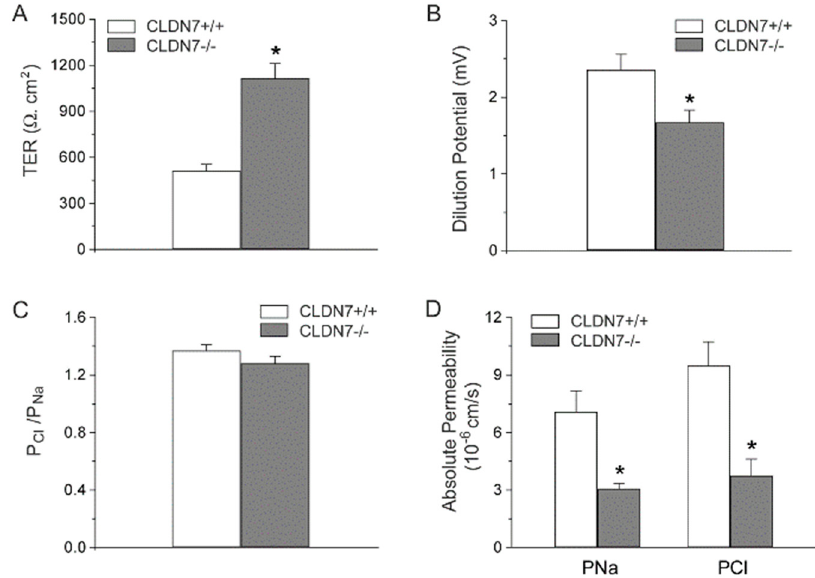
Figure 2. Deletion of CLDN7 increased transepithelial resistance (TER) and decreased paracellular Cl − and Na + permeability on CD cell monolayers. ( A ) TER was measured on monolayers cultured for 7 days. ( B ) CD cells were grown on collagen-coated Snapwell filters for 7 days to reach the full confluence. The filter rings containing cell monolayers were mounted into EasyMount chambers. Both apical and basal chambers were filled with buffer containing 140 mM NaCl. Subsequently, buffer in the basal chamber was replaced by 70 mM NaCl, and dilution potentials were measured. ( C ) The ratio of the absolute permeability of Cl - to Na + (P Cl /P Na ) was calculated using the Goldman–Hodgkin–Katz equation. The ratio of P Cl /P Na was >1 in CLDN7 +/+ , indicating that these CD cells were more permeable to Cl − than Na + . ( D ) The absolute permeability for P Cl and P Na was calculated according to the method of simplified Kimizuka and Koketsu equations. * p < 0.05. n = 3.